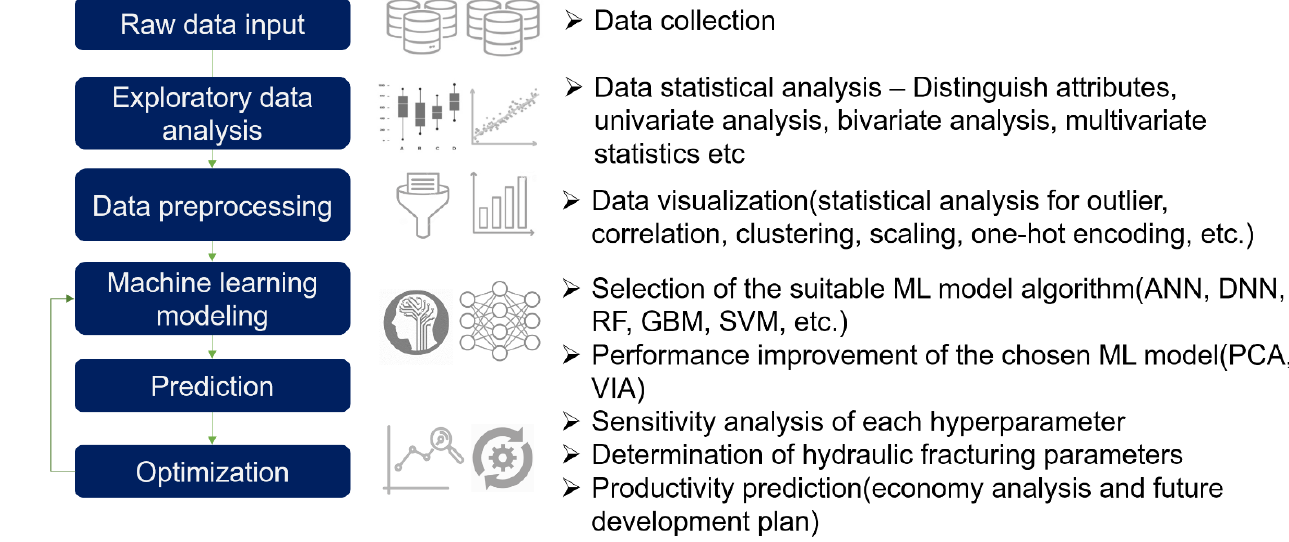
Figure 8. Flow chart of machine learning modeling for production forecasting based on the data-driven approach.